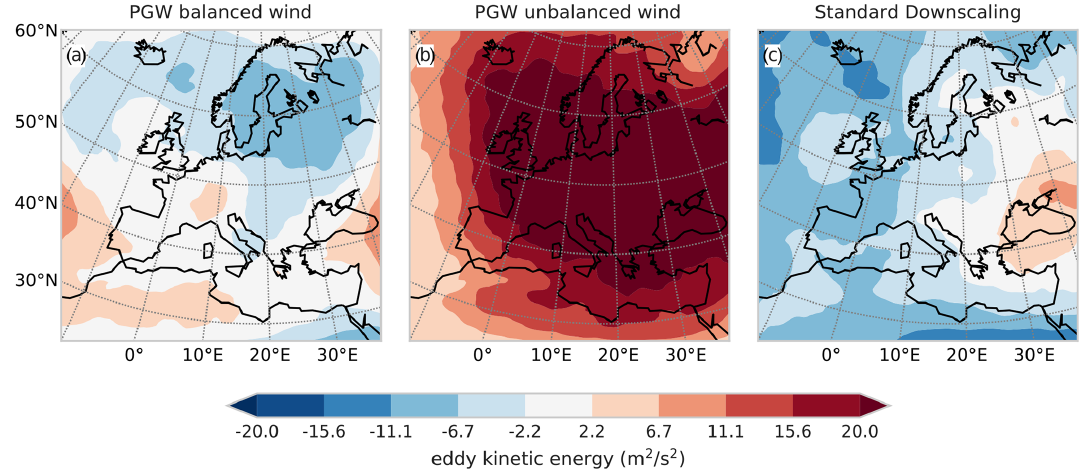
Figure 10. Effect of the thermal wind balance on changes in 500hPa eddy kinetic energy (EKE) in PGW simulations. (a) PGW simulation where both changes in temperature and wind were made at the lateral boundaries and therefore the thermal wind balance was maintained. (b) PGW simulation where the temperature at the lateral boundaries was changed without corresponding changes in wind. (c) EKE changes from dynamically downscaling the same GCM. Details on the simulations in Table